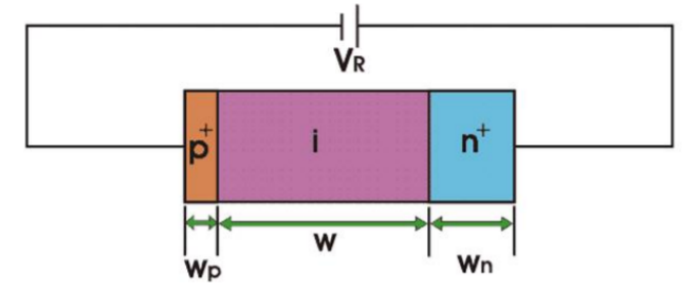
Figure 8. Circuit of a PIN junction, where W is the intrinsic layer width.